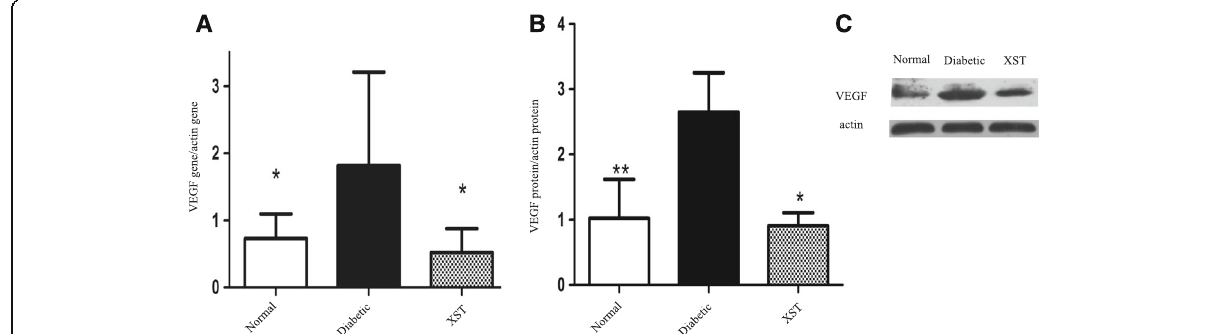
Fig. 5 The effect of XST on gene and expression levels of VEGF. a The gene level of VEGF was determined by PCR. XST lead to a reduction of VEGF gene level. b – c The protein level of VEGF was evaluated by WB. XST displayed a decrease of VEGF protein level. Data were represented as mean ± S.D. ( n = 3 – 4).*: P < 0.05, **: P < 0.01, compared to